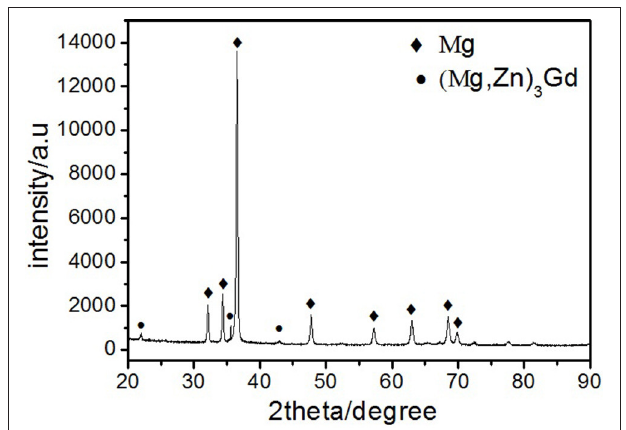
FIGURE 2 | XRD patterns of the as-cast Mg-2.0Zn-0.5Zr-3.0Gd alloy.